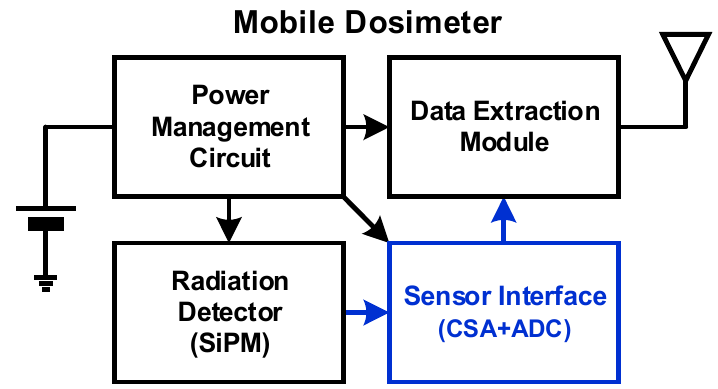
Figure 1. Block diagram of a mobile dosimeter.